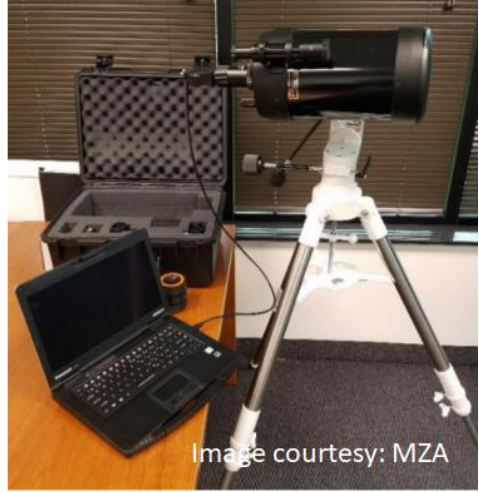
Figure 1. DELTA turbulence profiling system.